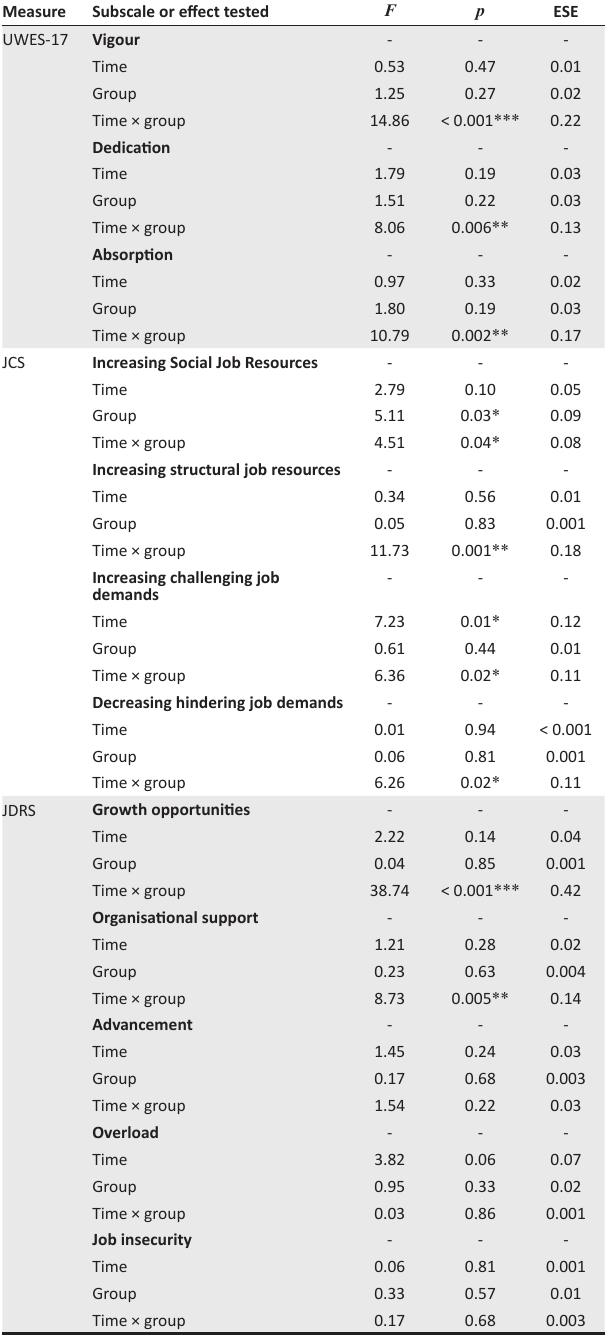
TABLE 4: Repeated-measures analysis of variance: Change in work engagement, job crafting and job resources-demands scores from pre- to post-intervention in the two groups ( N =